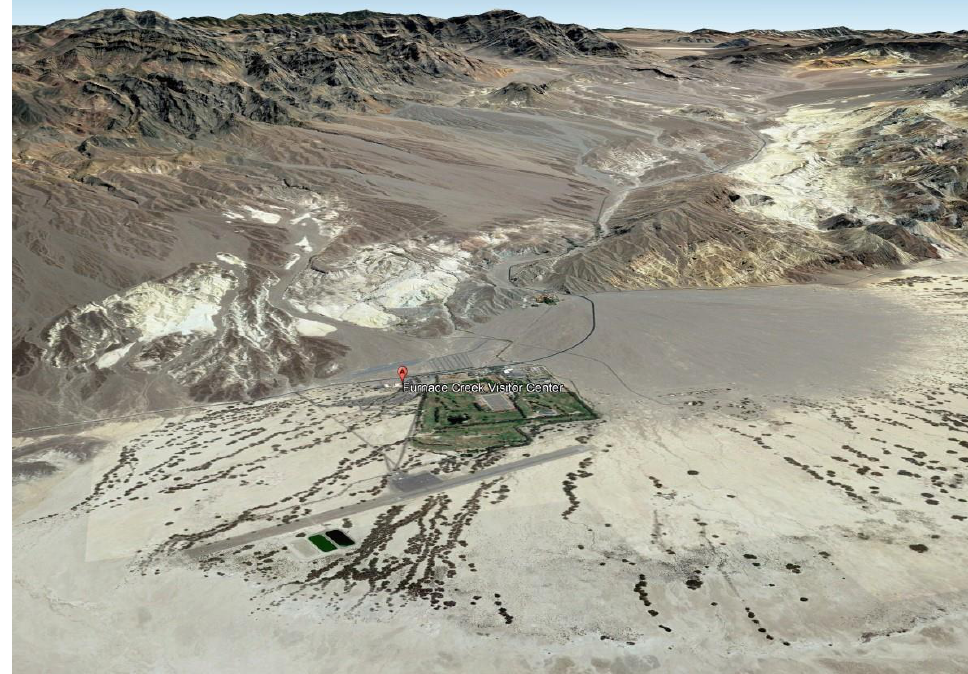
Figure 14. Furnace Creek visitor centre: airport, hotels, and campground area present (from Google Earth Pro V 7.3.4, (6 September 2015), 36°27′39.76″N, 116°51′41.36″W, Eye alt 2.07 km, Landsat, Copernicus, CNES, Airbus, Maxar Technologies/USDA/FPAC/GEO 2022, [46]).